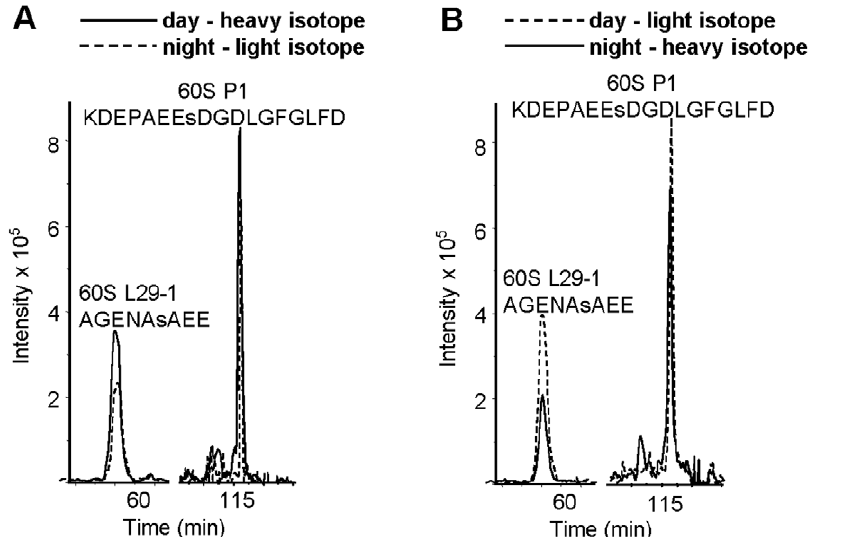
Figure 4. Quantitative mass spectrometric analysis of phosphorylated peptides from the 60S ribosomal protein L29-1 and from the 60S acidic ribosomal protein P1. A , ion chromatograms of phosphorylated peptides from the plants harvested during day labeled with heavy isotope (continuous line) and from the plants harvested during night labeled with light isotope (dashed line). The sequences of two phosphorylated peptides: AGENAs 58 AEE (M/Z=1025.3 for heavy and M/Z=1013.3 for light isotope labeled peptide) from the 60S ribosomal protein L29-1 and KDEPAEEs 103 DGDLGFGLFD (M/Z=1078.9 for heavy and M/Z=1066.9 for light isotope labeled peptide) from the 60S acidic ribosomal protein P1 are shown above the corresponding ion intensity peaks. B, ion intensity peaks as in A except that peptides from the plants harvested during day were labeled with light isotope (dashed line) and peptides from the plants harvested at night with heavy isotope (continuous line).